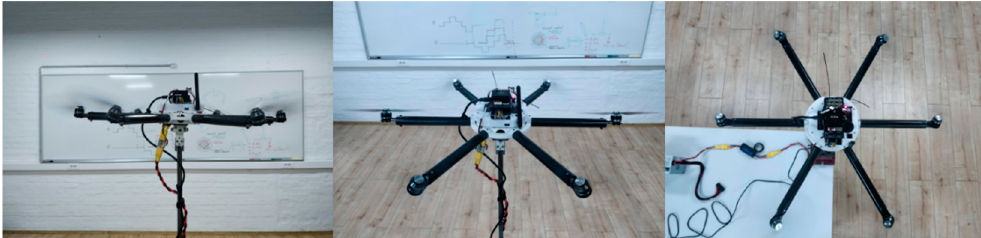
Figure 20. Experimental testing of attitude control on fully-actuated non-flat hexarotor configuration (NFX6).